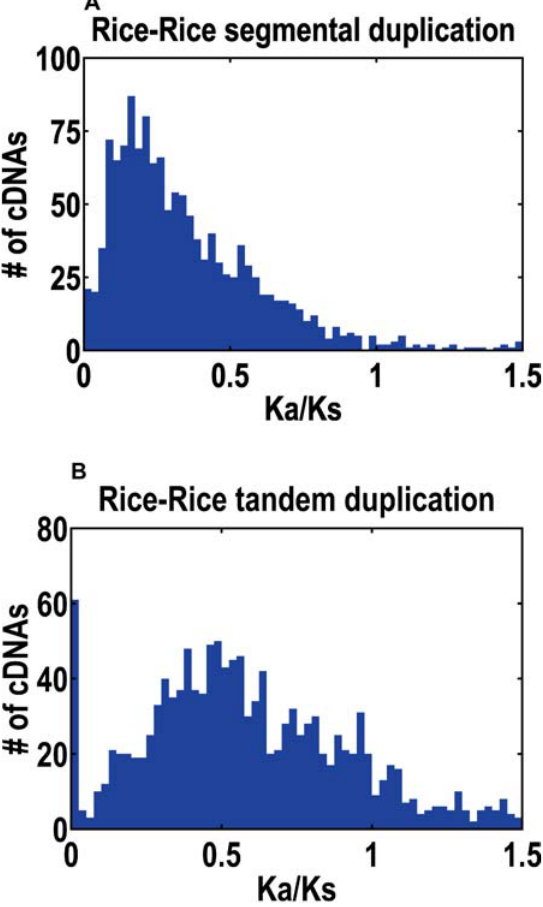
Figure 10. Ka/Ks Distribution for Homolog Pairs Ka and Ks are the fraction of the available nonsynonymous and synonymous sites that are changed in the homolog pairs. Ka/Ks . 1 is an indicator of positive selection. Shown is the Ka/Ks distribution for segmental duplications (A) and for tandem duplications (B). DOI: